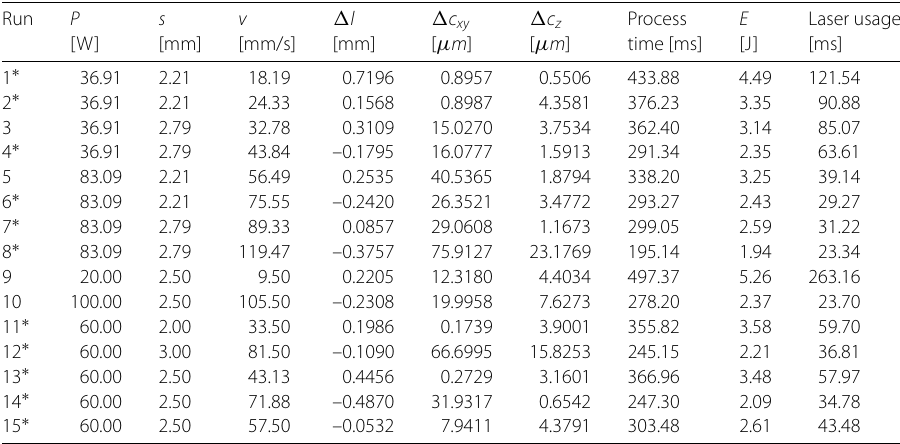
Table 4 Case Study 2: Results of initial experimental design. A star in the first column indicates that it is a final Pareto solution